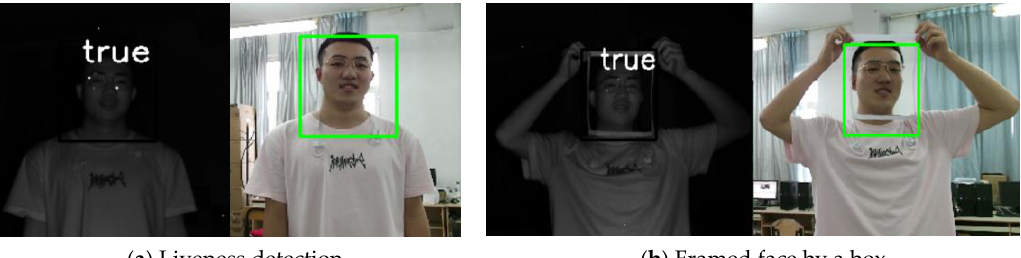
Figure 9. Positive samples.